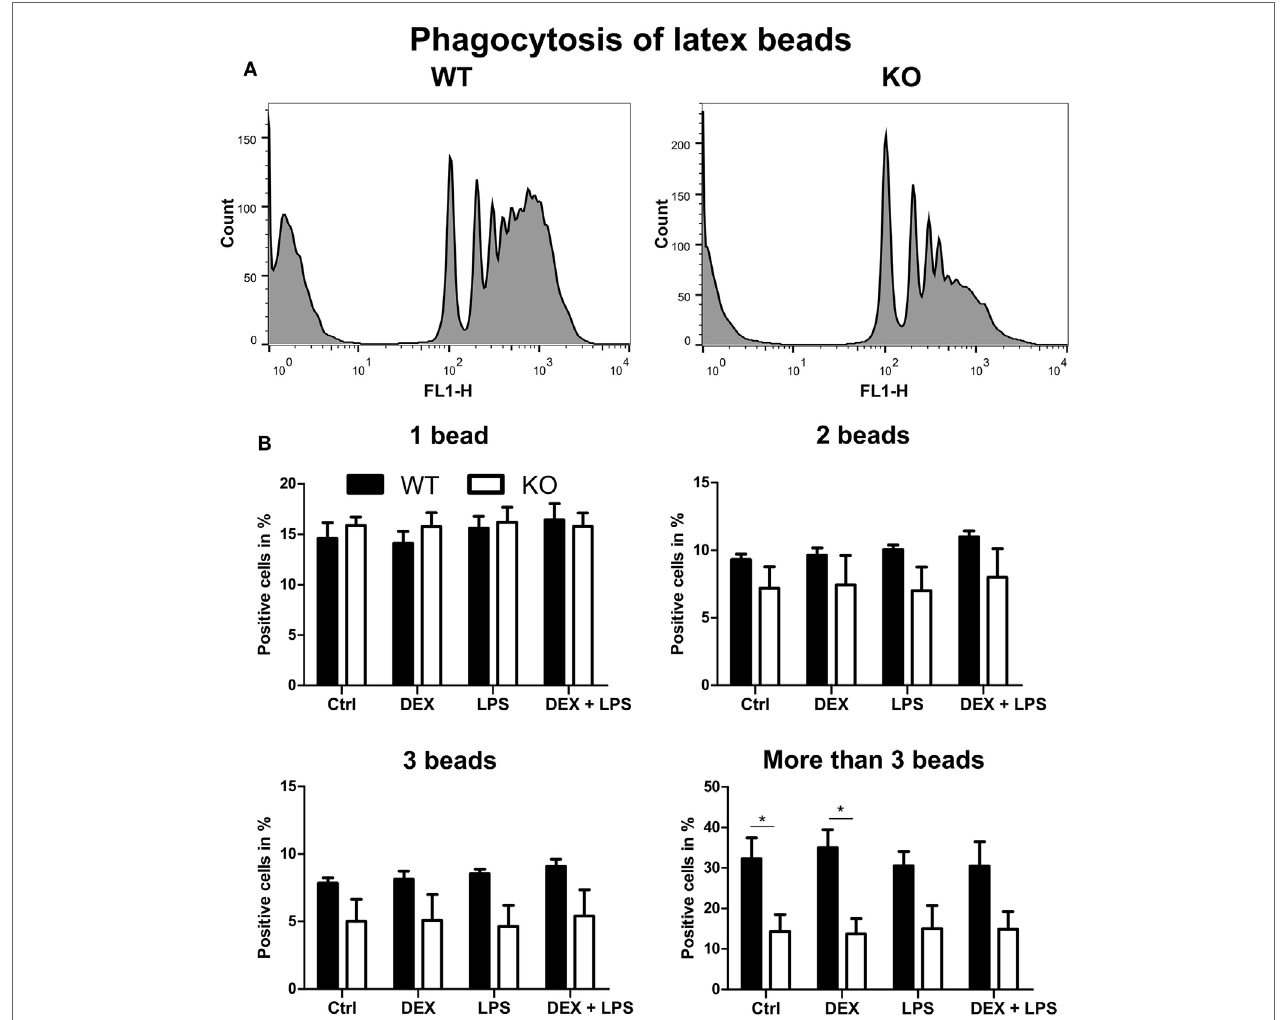
FigUre 6 | Peroxisome proliferator-activated receptor- γ -deficient macrophages show impaired phagocytosis of latex beads. (a,B) ER-Hoxb8 macrophages d5 were treated with dexamethasone (DEX) (100 nM) and/or LPS (1 µg/ml) for 48 h. Subsequently, cells were incubated with fluorescent latex beads for 2 h at a ratio of 10 beads per cells. The phagocytosis was determined in FACS. (a) The histograms display results from one representative experiment out of five performed. (B) Phagocytosing cells were split into four groups depending on the number of engulfed beads. The bars represent the mean with the SEM of five independent experiments (* p < 0.05) (calculated by using two-way